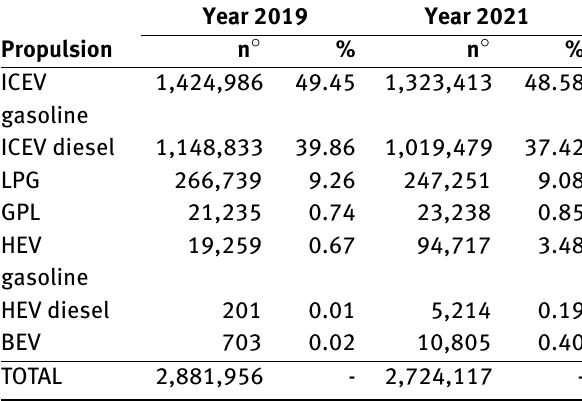
Table 2: Vehicle fleet composition circulating in Rome in 2019 and 2021 [24, 25]